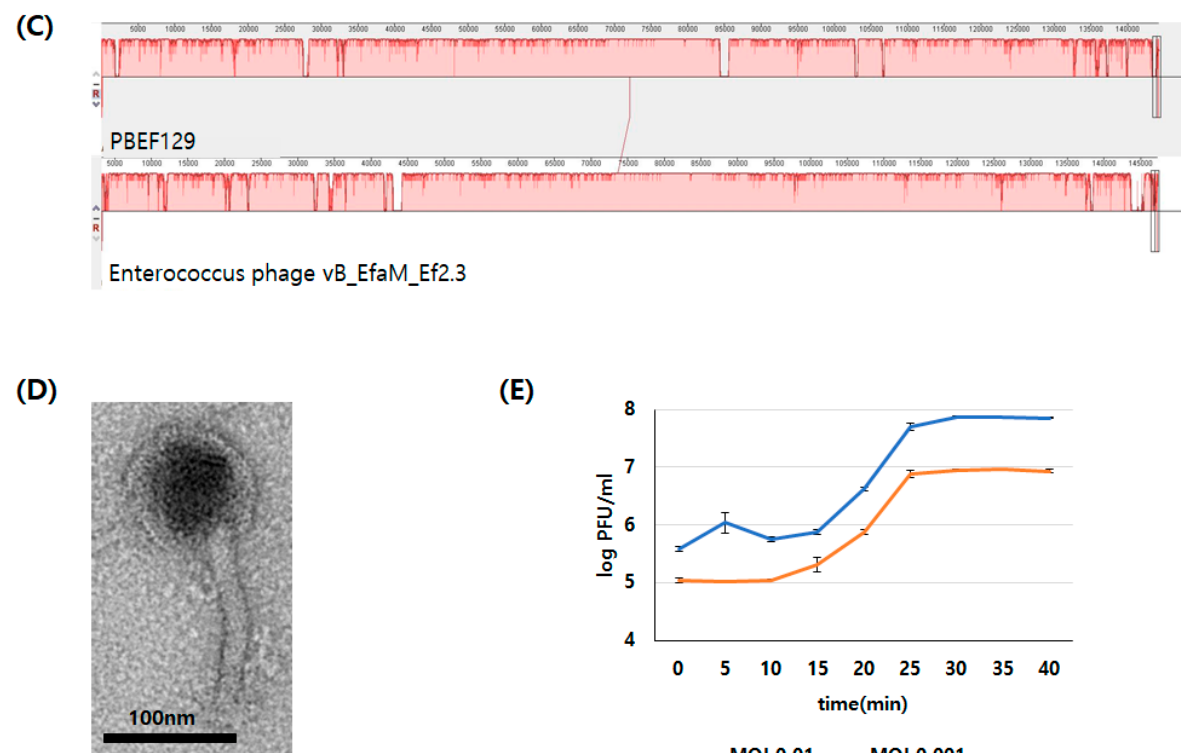
Figure 1. Genomic analysis of the bacteriophage PBEF129. ( A ) Open reading frame (ORF) map. Each arrow represents a functionally annotated ORF color coded according to its function. Blue, structural protein; green, replication and regulation; yellow, lysis; red, DNA packaging; violet, unspecified phage protein; white, uncharacterized. ( B ) Genomic tree showing distances among related phages. Red rhombus indicates PBEF129. The tree was drawn based on the genes encoding tail fibers of each phage. Bootstrap values are shown. ( C ) Alignment of whole genomes of phage PBEF129 and the closest phage vB_EfaM_Ef2 using MAUVE. ( D ) TEM image of phage PBEF129 shown with a scale bar. ( E ) One-step multiplication of phage PBEF129.